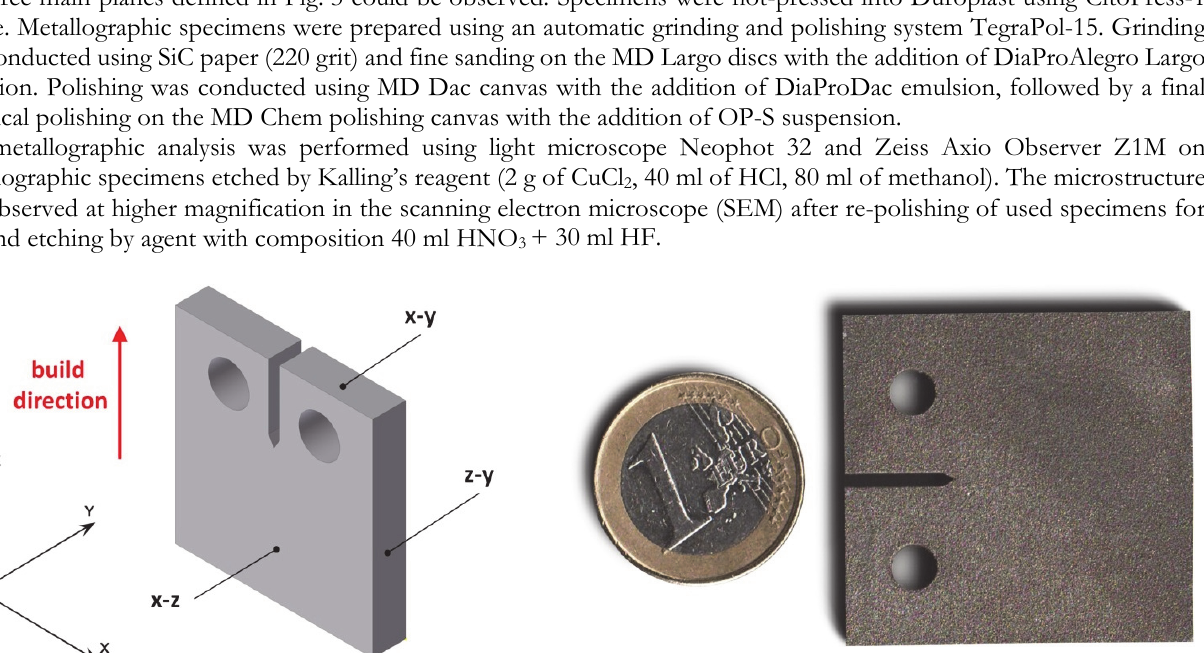
Figure 4: CT specimen made of SLM Inconel